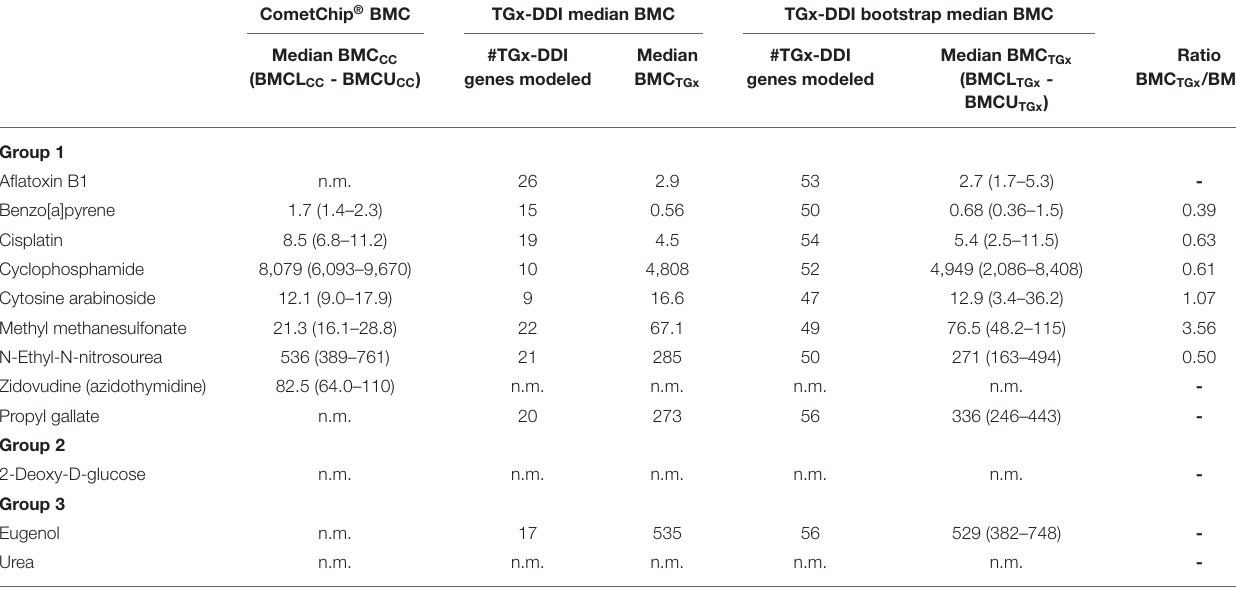
TABLE 4 | Comparison of benchmark concentrations for CometChip ® (BMC CC ) and TGx-DDI biomarker genes (BMC TGx